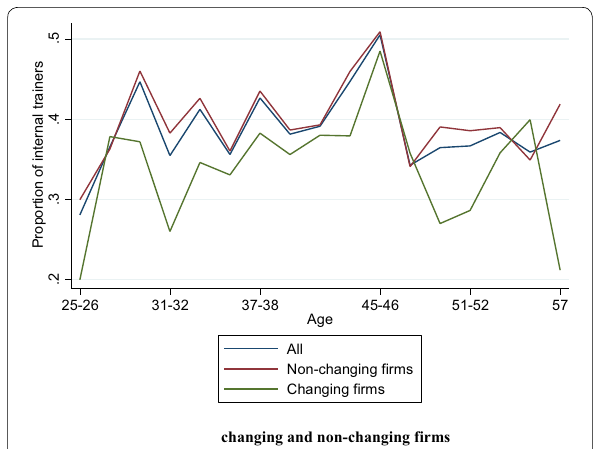
Fig. 1 Share of internal trainers by age in changing and non‑ changing firms. Source: COI survey 2006/INSEE‑DARES‑CEE. Coverage: Workers aged 45–57 years old with at least 1 year of seniority and employed in firms with 20 workers or more. Changing firms corre‑ spond to firms that have experienced substantial ICT and manage‑ ment